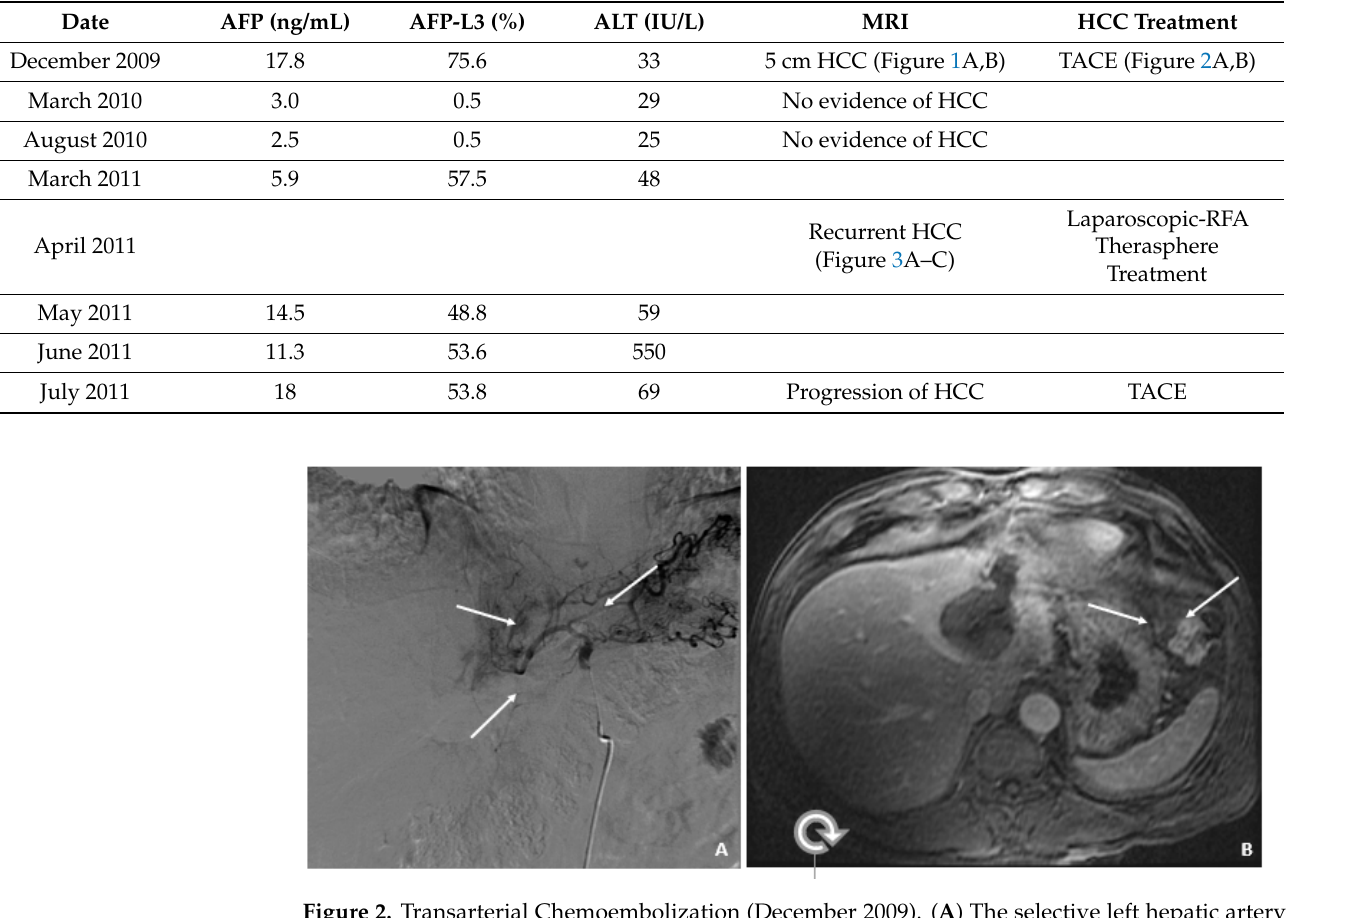
Figure 2. Transarterial Chemoembolization (December 2009). ( A ) The selective left hepatic artery injection shows a blush of contrast corresponding to the hypervascular tumor (arrows). ( B ) An axial T1-weighted fat-suppressed portal-phase postcontrast MRI image 4 weeks following TACE shows lack of enhancement in the treated lesion with a small adjacent focus of necrosis (arrows).